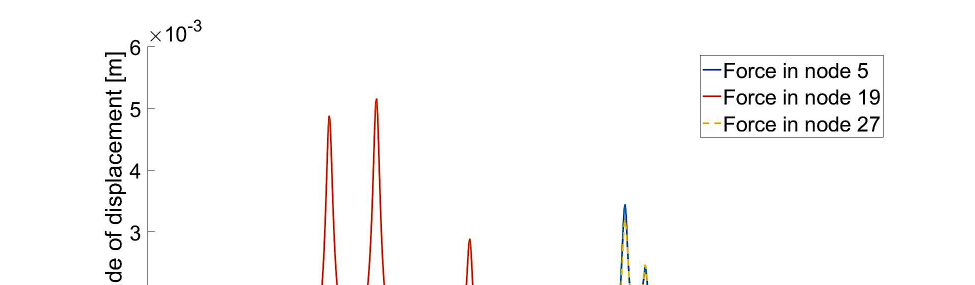
Figure 1. Static scheme of the bridge.